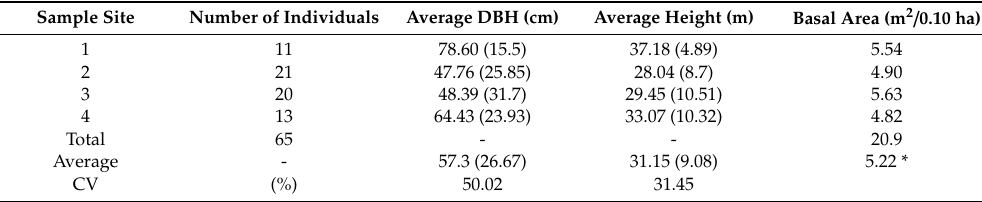
Table 3. Forest biometric variables of the tree structure in the La Joya sites.